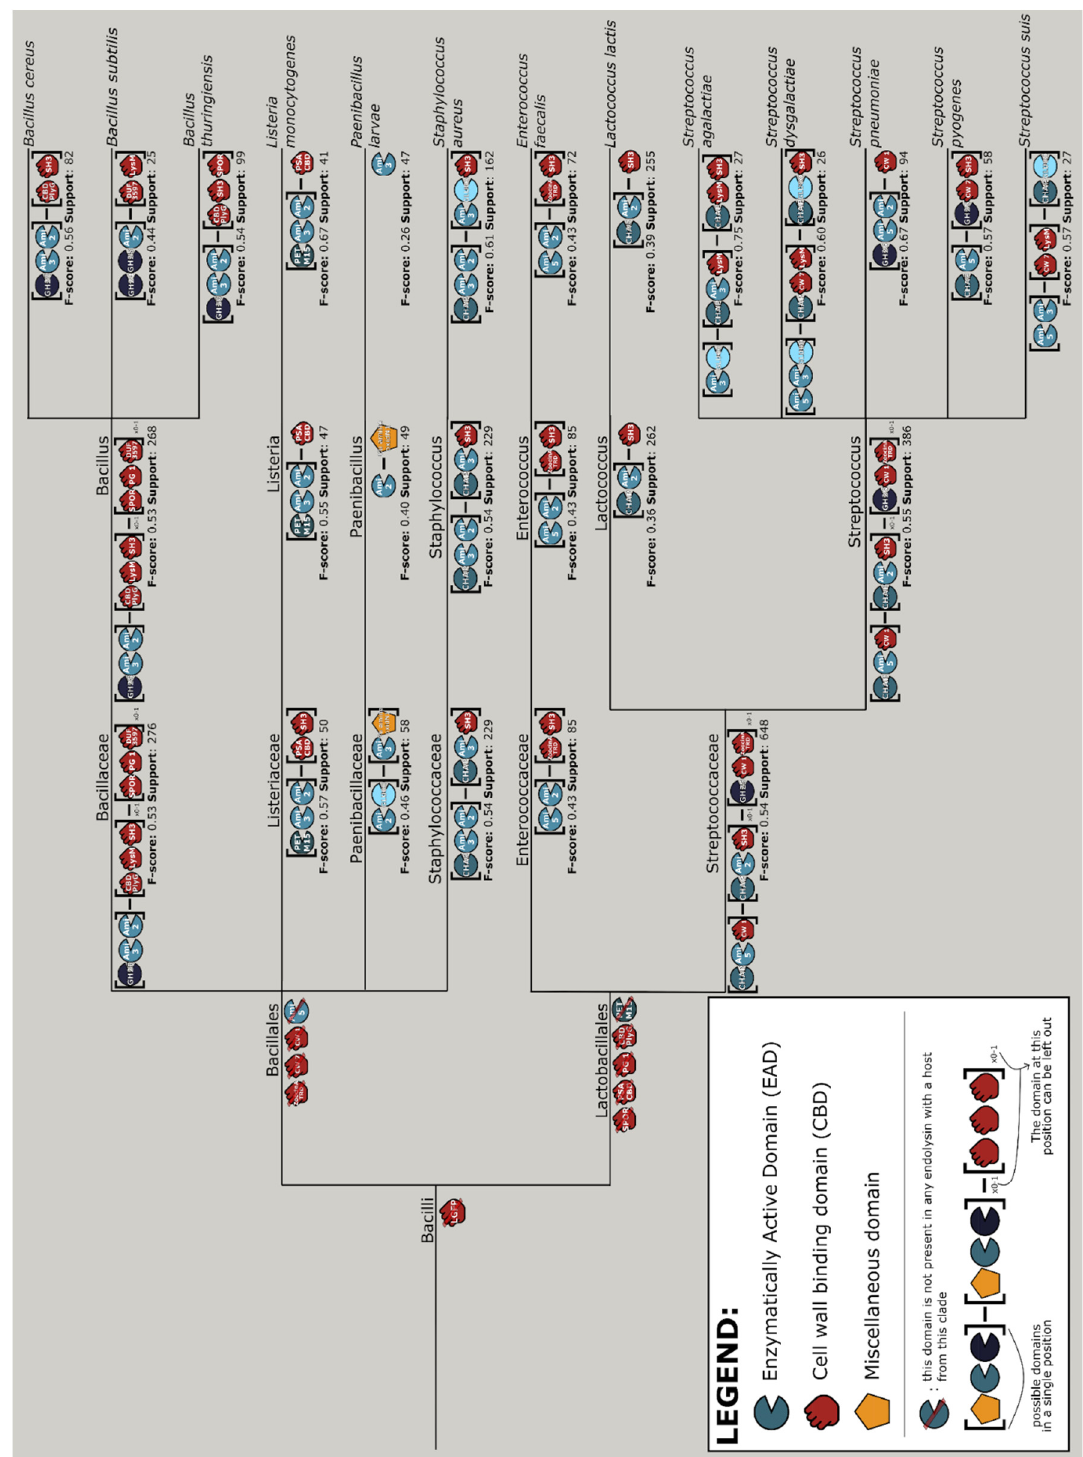
Figure 7. Design tree of phage lytic proteins targeting bacteria from the Bacilli class. Per position, square brackets contain different domains that can occur at that position. To simplify the designs, CBD homorepeats were condensed to a single occurrence of the domain. To accommodate for architectures of one up to three domains, the subscript “x0-1” has been added to indicate domains that either do not occur or occur once. Domains are color-coded based on their annotation as EAD (blue), CBD (red) or miscellaneous (yellow). The figure also provides the F-score as a measure of how many of the actual architectures fit the rule, as well the support, signifying the total amount of proteins corresponding to this branch. Due to its size, this figure is best viewed digitally. An analogous design tree of phage lytic proteins targeting bacteria from all phyla in PhaLP is available in the supplementary material in text-based format (File S2).